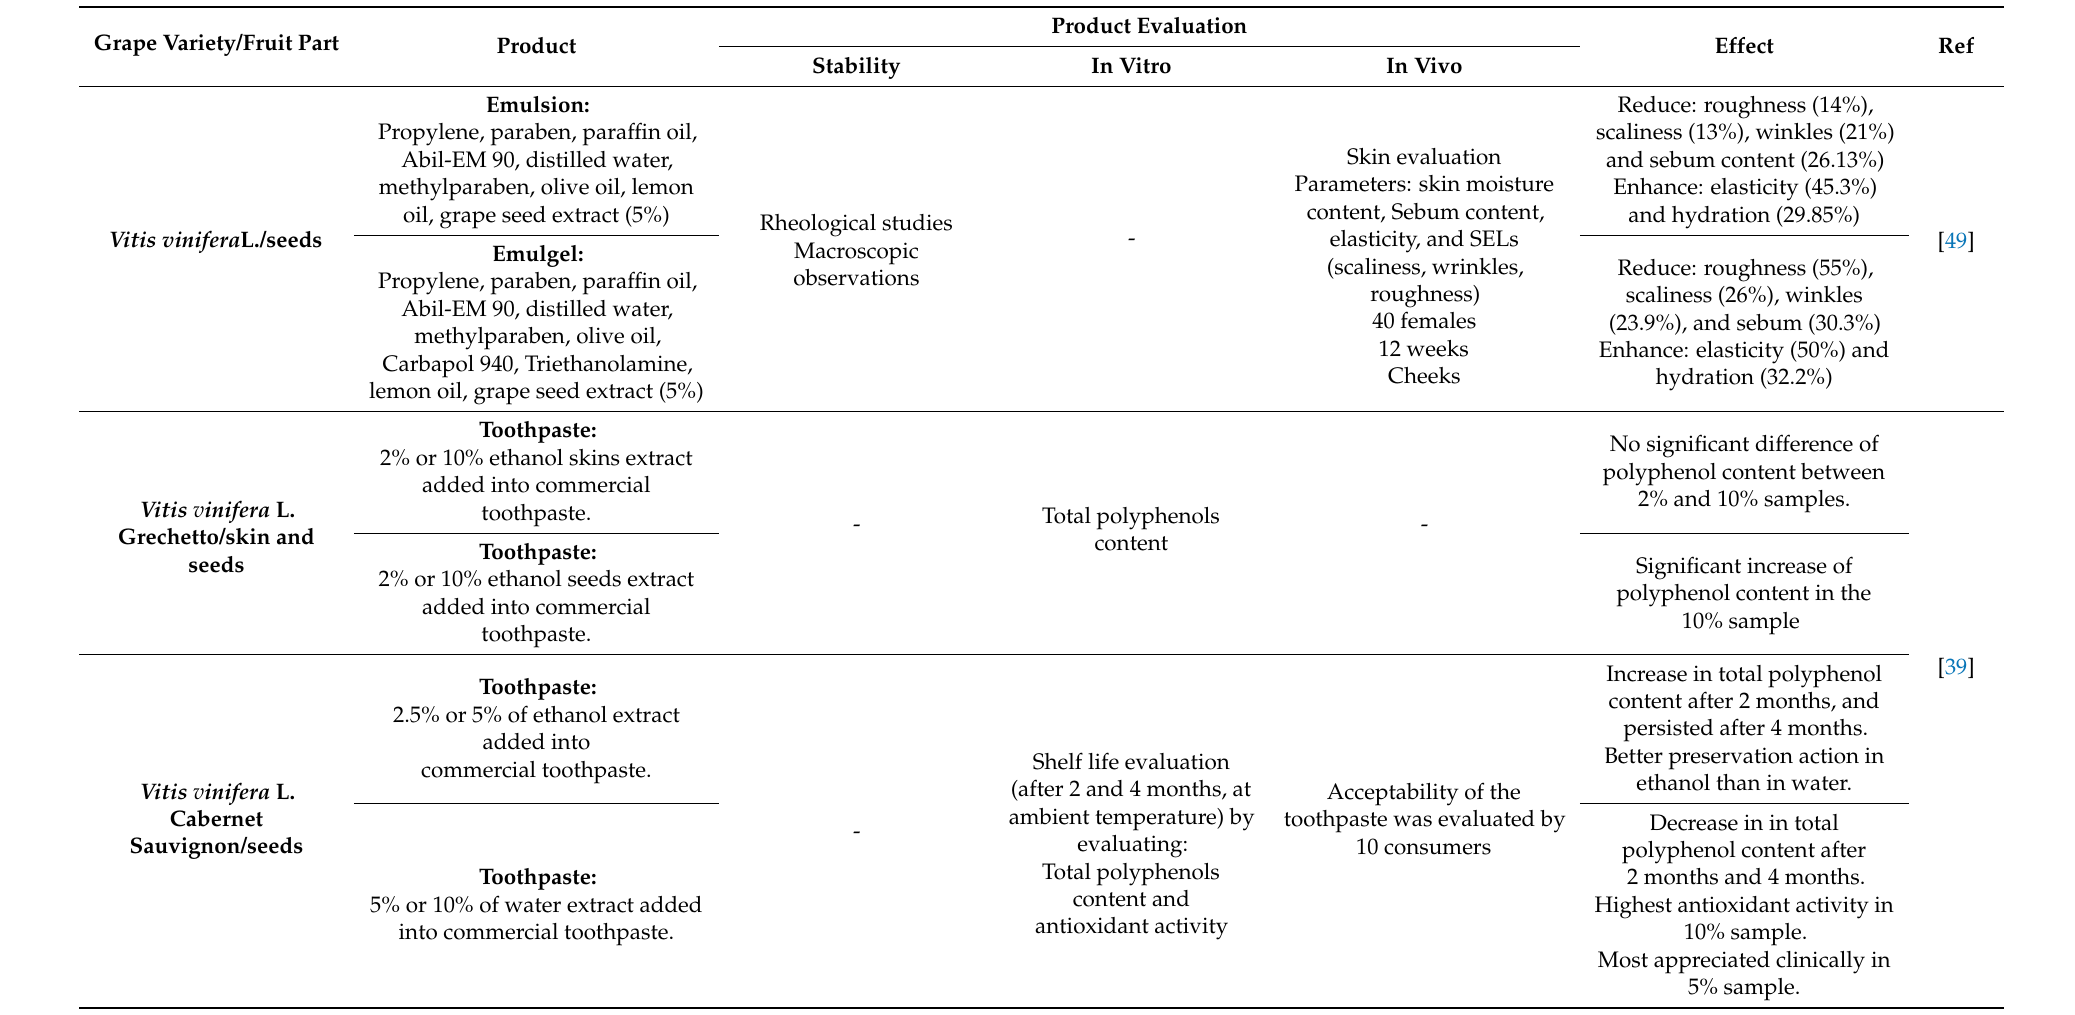
Table 3. Formulation of the incorporated grape extracts in different cosmetic products, evaluation and